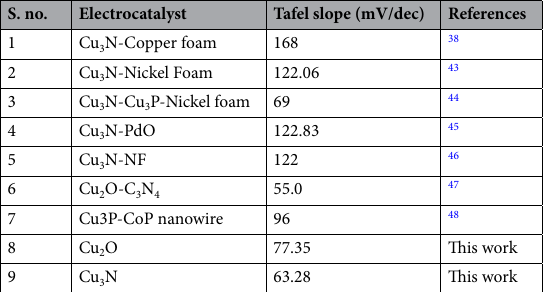
Table 1. A table of comparison of the reported catalysts with the present material reported in this work.